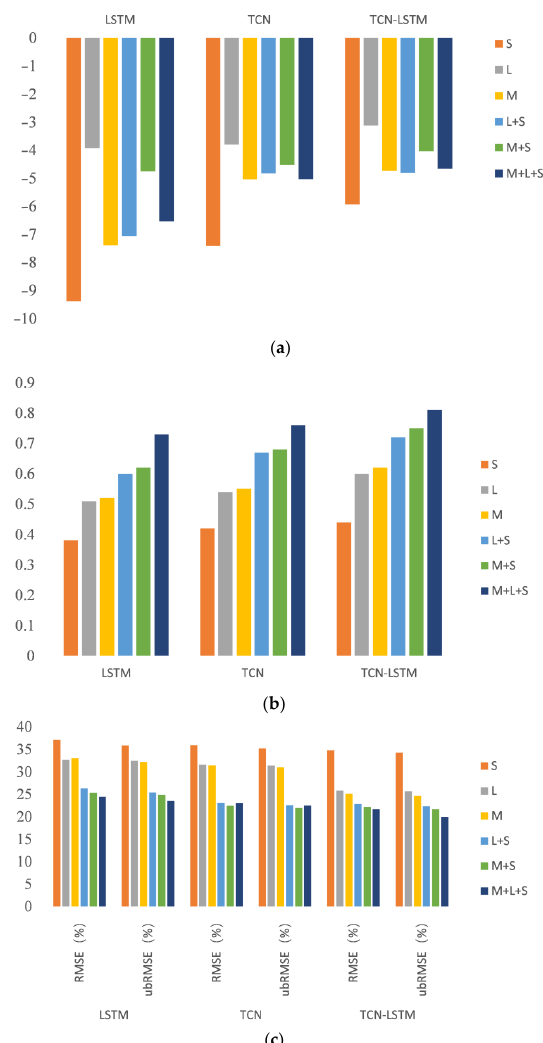
Figure 5. Evaluation indicators of LFMC retrieval results based on LSTM, TCN and TCN-LSTM. ( a ) Bias; ( b ) R 2 ; ( c ) RMSE and ubRMSE. S represents Sentinel-1 data, L represents Landsat8 data, M represents MODIS data.